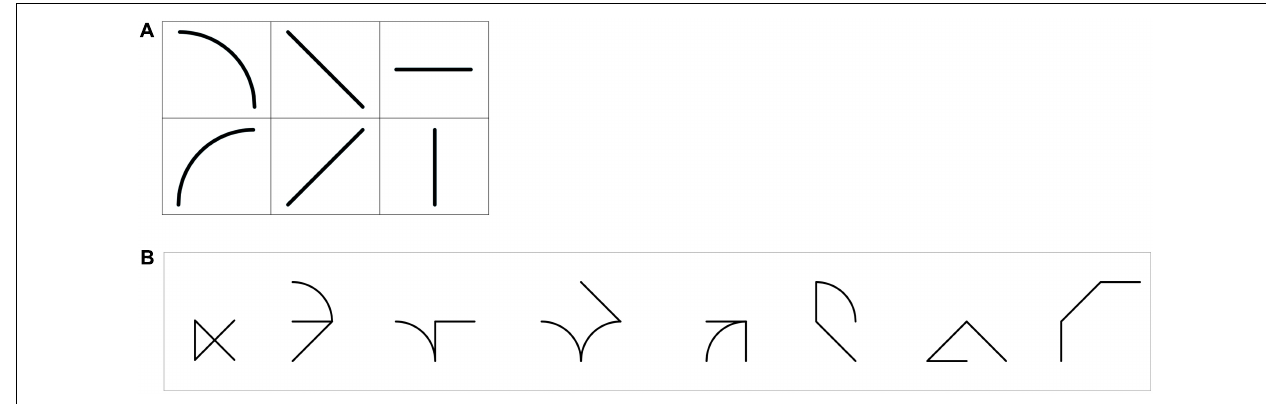
FIGURE 1 | (A) The six elementary features used to construct the symbol library. (B) The eight symbols to be learned.